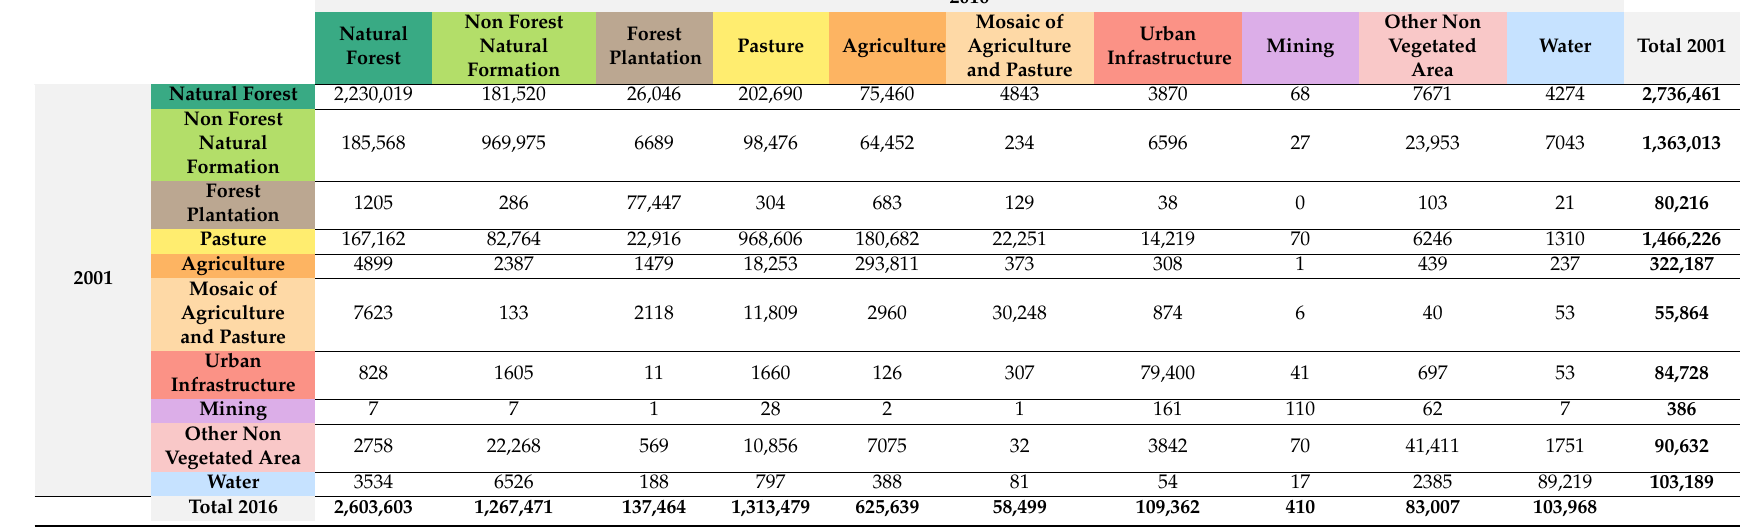
Table A5. LULC transition matrix of the BZs. Entries correspond to the surface area expressed in